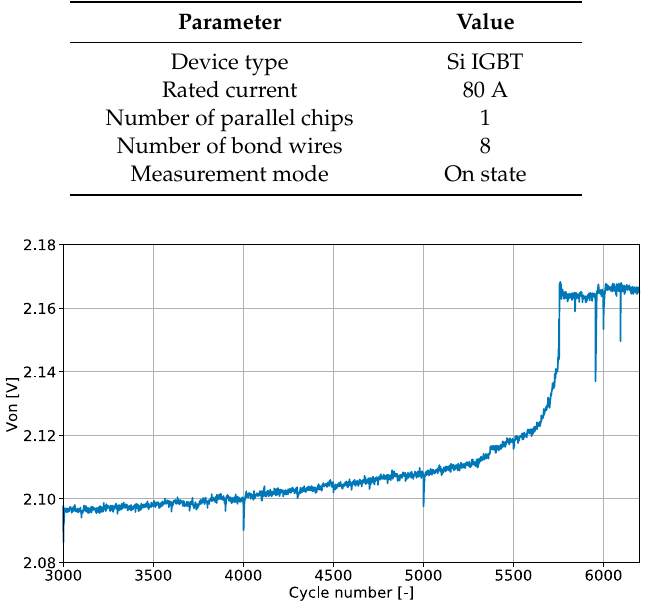
Table 3. Parameters of the sample used for the experiment shown in Figure 7.